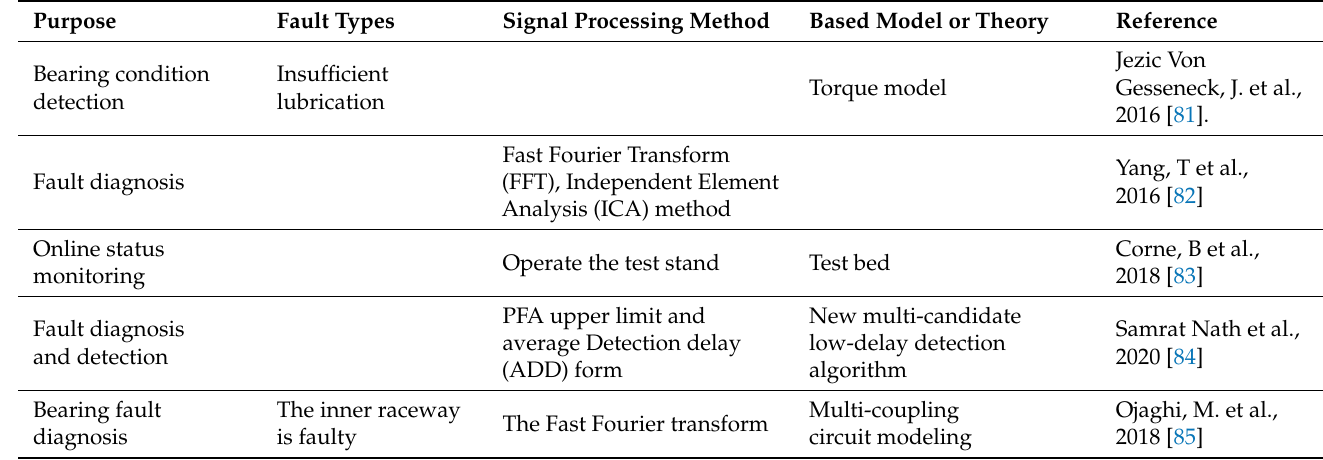
Table 7. Summary and comparison table of remote real-time monitoring